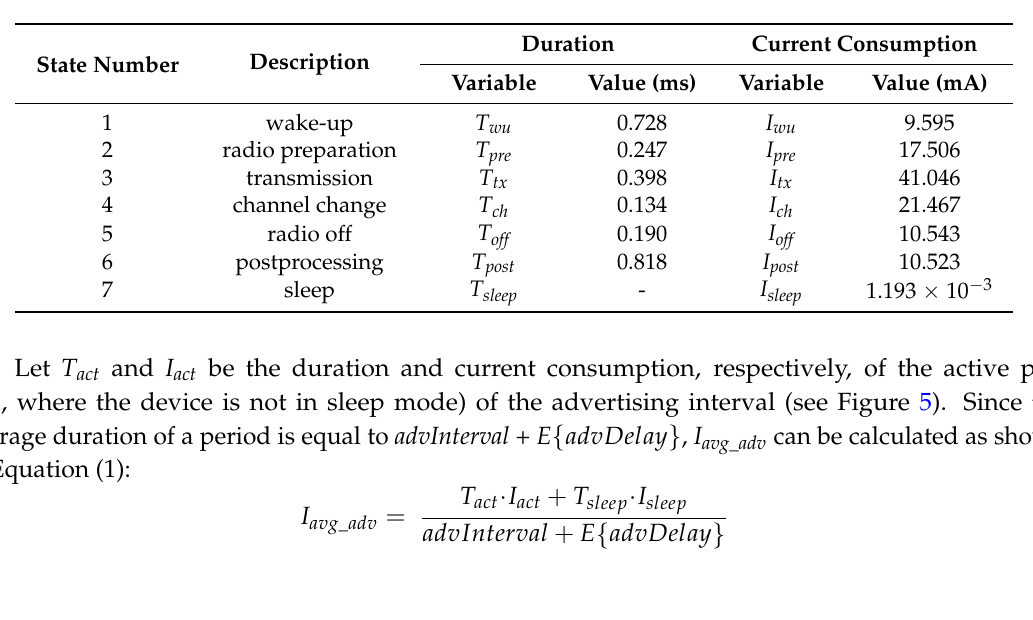
Figure 4. Current consumption profile of an advertising event for the BLE121LR platform operating as a non-connectable advertiser. Three-advertisement (leftmost) and single-advertisement (rightmost) advertising events are shown. Table 1. Definition of states and relevant variables for the advertisement-based approach. In the measurements, the slow clock function offered by the BLE121LR platform was disabled.